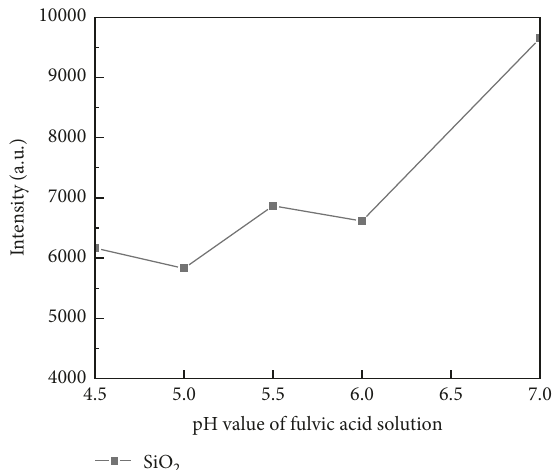
Figure 13: Relationship curve between main diffraction peaks and of SiO 2 and pH value of FA solution.